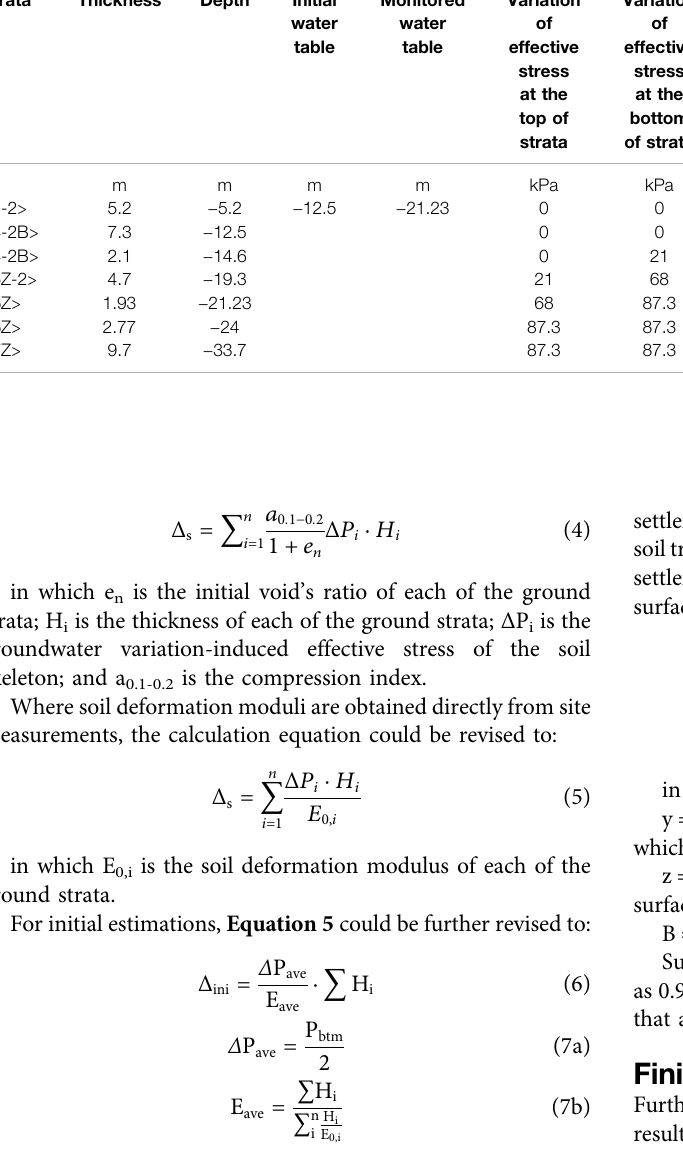
Total settlement